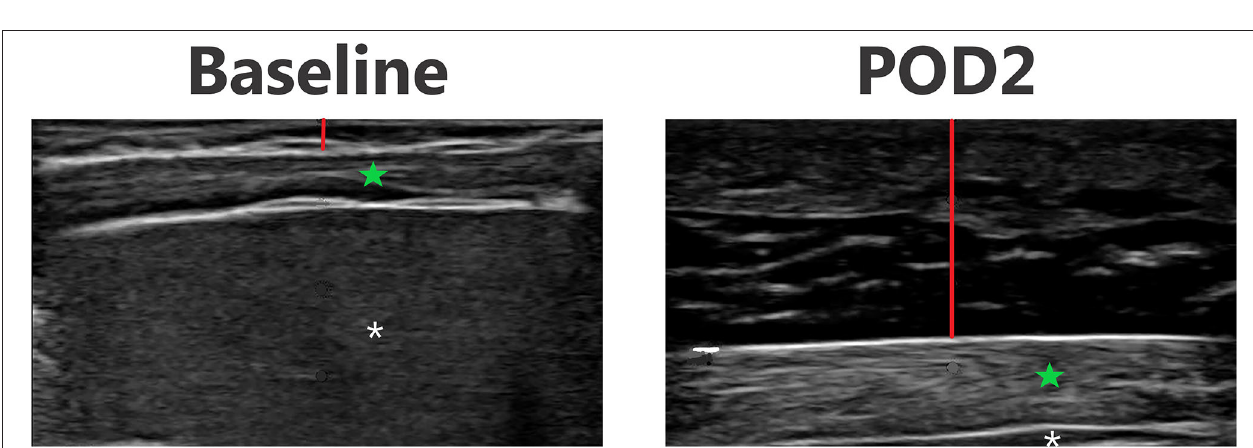
FIGURE 5 | Point-of-care ultrasound images of lateral abdomen at baseline and POD 2 of the same patient. Both images are presented on identical scales (total depth of 2cm from the skin). Red vertical line demonstrates subcutaneous tissue thickness—there is a marked increase in subcutaneous tissue seen on POD 2. Green star—echogenic muscle changes seen on POD 2. White asterisk—liver.